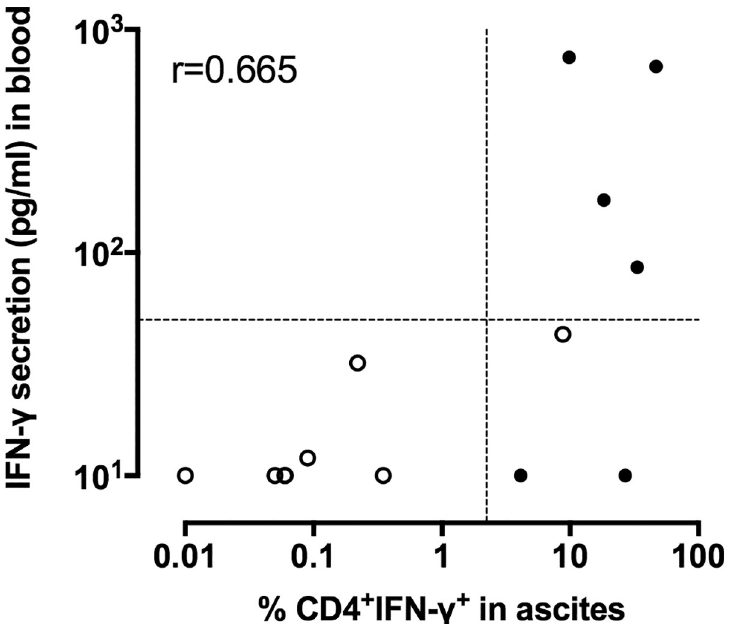
Fig 6. Comparison of the peripheral blood and peritoneal cell IFN- γ -responses to ESAT-6. Ascites lymphocytes were in vitro cultured overnight in the absence (medium) or the presence of ESAT-6, and the percentages of IFN- γ - containing CD4 + T lymphocytes were analyzed by flow cytometry. Peripheral blood mononuclear cells were in vitro cultured overnight in the absence or the presence of ESAT-6, and the concentration of IFN- γ -released was measured by ELISA. The values obtained in the absence of antigen stimulation were subtracted from those obtained in response to mycobacterial antigens for both the flow cytometry and the ELISA results. Filled circles represent values from patients suffering from TB, whereas open circles represent values from non-TB patients. r: Spearman coefficient of correlation.